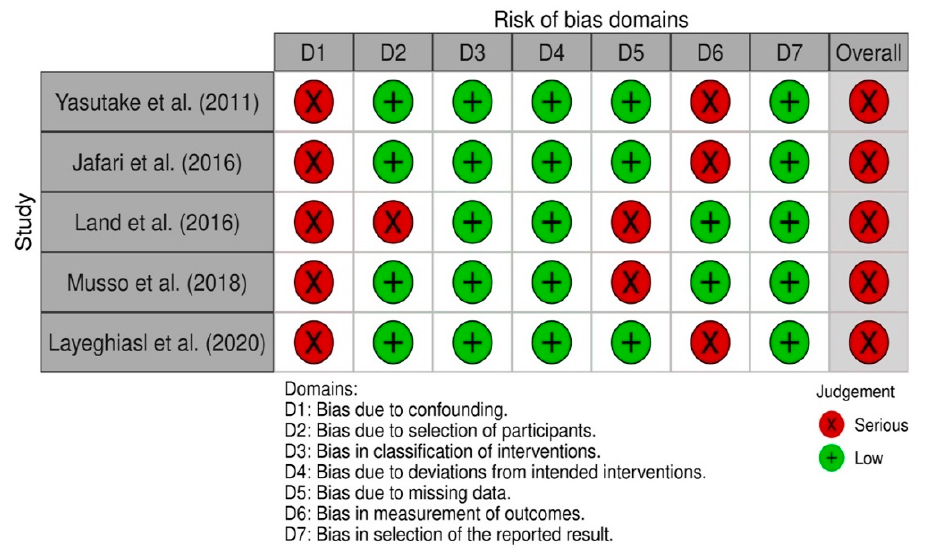
Figure 3 . Risk of bias summary for nonrandomized studies (ROBINS-I tool). Figure 3. Risk of bias summary for nonrandomized studies (ROBINS-I